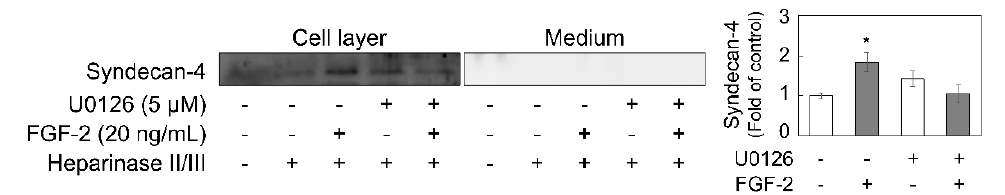
Figure 5. Effects of MEK1/2 inhibitor U0126 on the expression of syndecan-4 core protein expression in the dense culture of vascular endothelial cells. The dense culture of vascular endothelial cells was pretreated with 5 µM MEK1/2 inhibitor U0126 at 37 °C for 3 h and then stimulated with 20 ng/mL FGF-2 for 6 h, and assessed for the syndecan-4 core protein level by western blotting. The bar graph shows the intensity of syndecan-4 in the cell layer in the group treated with heparinase II/III. The values in the bar graphs indicate the means ± S.E. of three samples of the experiments. *Significantly different from the control, p < 0.05.